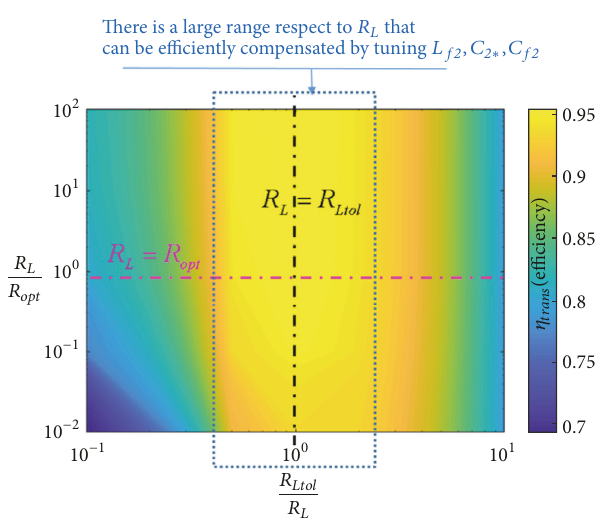
Figure 15: LCC compensation, behaviorof power transfer efficiency with respect to R